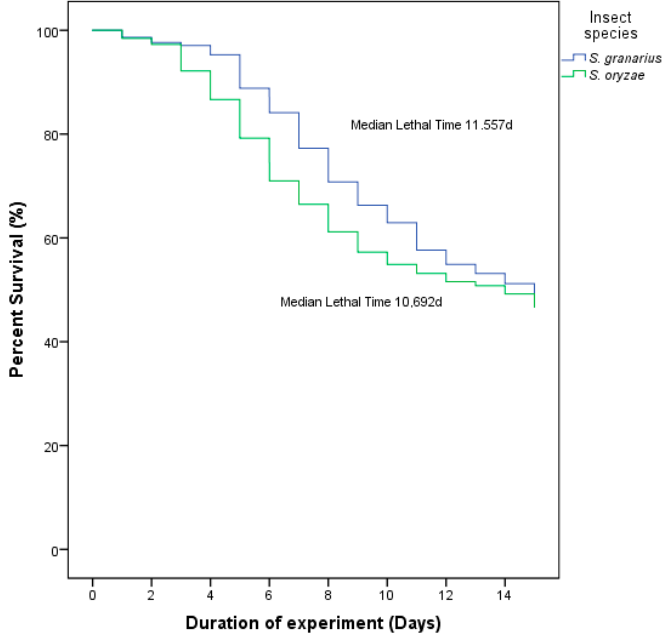
Figure 2. Overall survival of the infected adults of S. granarius and S. oryzae was monitored for 15 days, after being treated with B. bassiana (Bb) and I. fumosorosea (If) (chi-square: 7.630; df: 1, p =